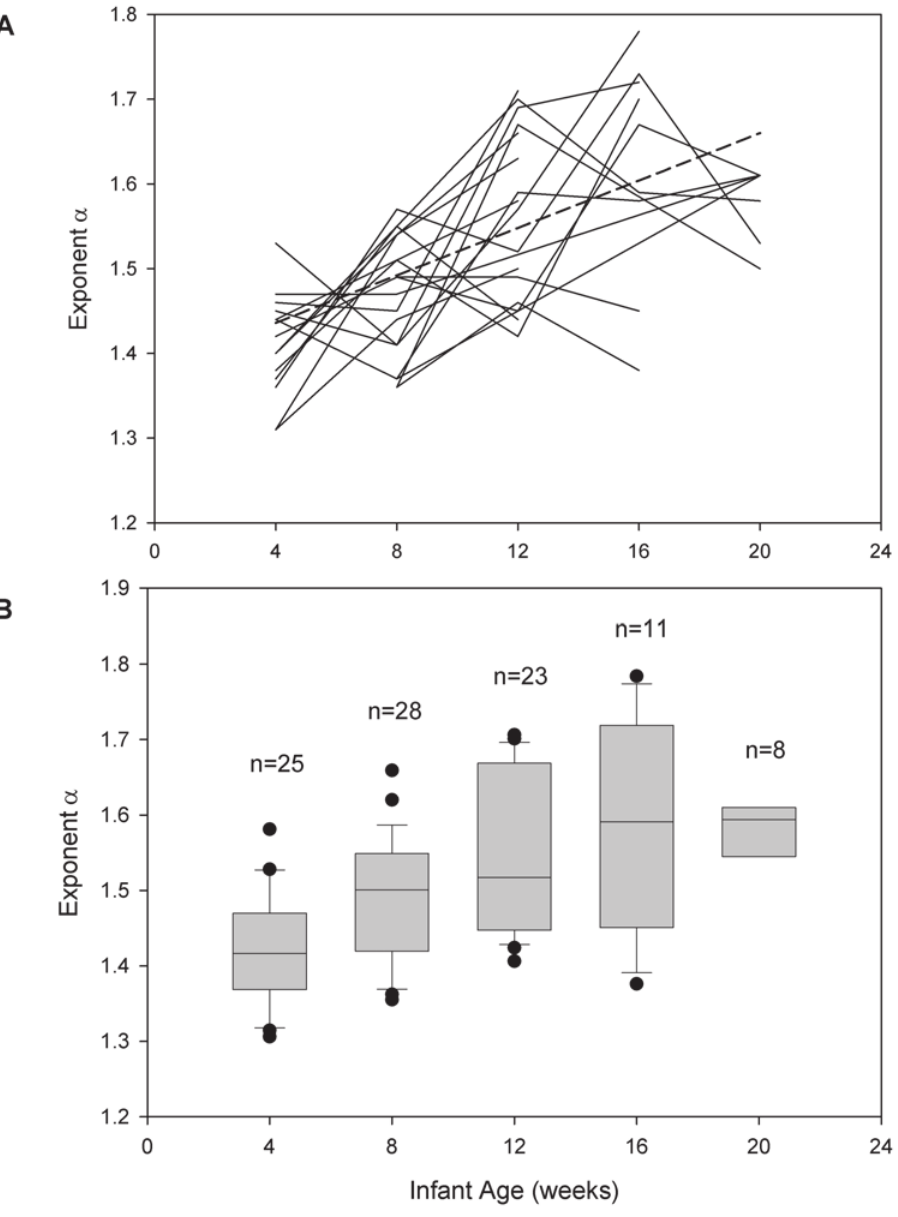
Figure 3. Change in a with age. a) Longitudinal measurements in infants with at least 3 measurements (solid lines). One infant had acceptable data from all 5 stages, 7 infants had acceptable data from 4 stages, and 10 from 3 stages. There is individual variability in the change in a with age, but there is an overall increase in a of 0.012 per week of age (95%CI 0.005 to 0.019, p=0.001) (dotted line). b) A box plot of a in all included infants grouped by age at 4, 8, 12, 16, and 20 weeks. The boundary of the box closest to zero indicates the 25 th percentile, the line within the box marks the median, the black dots are the outliers, and the boundary of the box farthest from zero indicates the 75 th percentile. Error bars above and below the box indicate the 90 th and 10 th